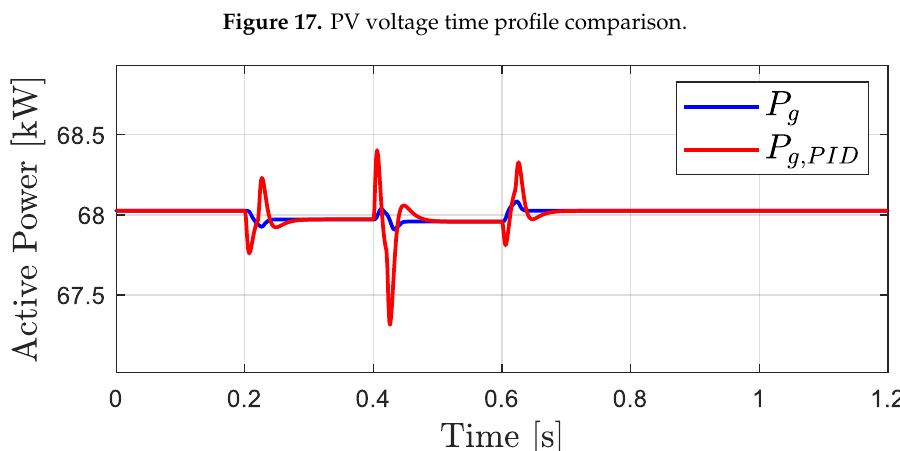
Figure 18. Active power to the grid time profile comparison.